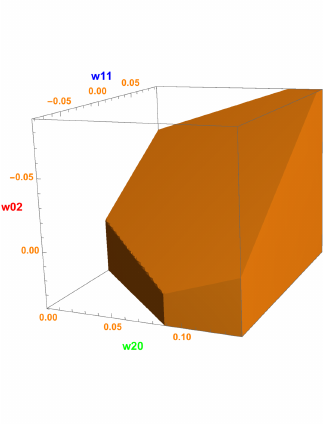
Figure 4. The 3d region obtained when we project down to w 02 , w 11 and w 20